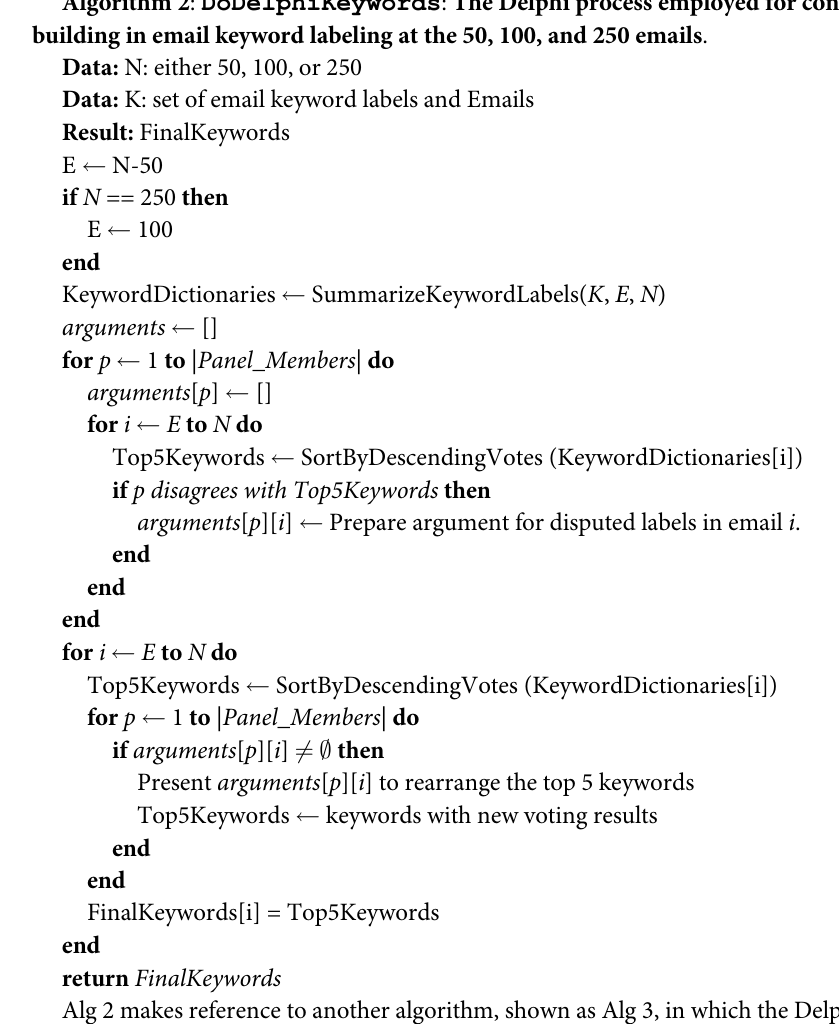
Algorithm 2 : DoDelphiKeywords : The Delphi process employed for